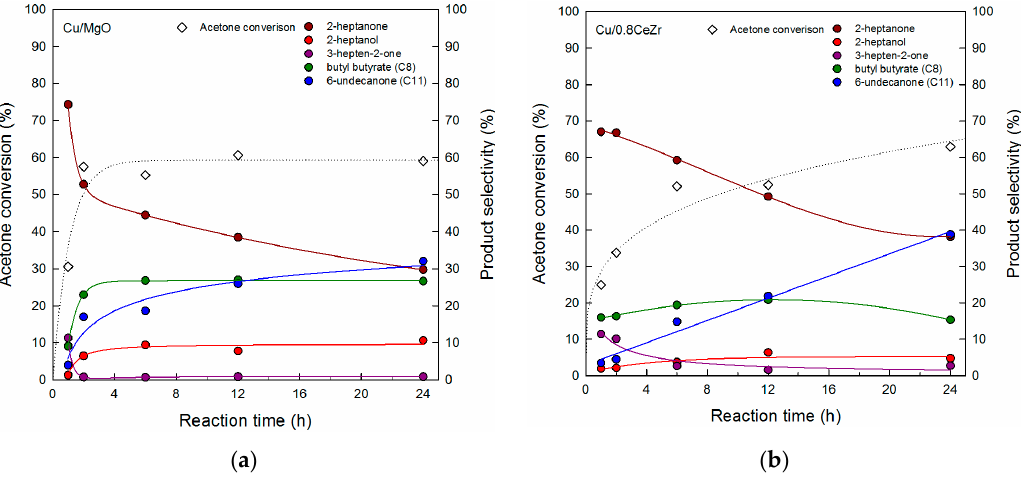
Figure 9. Acetone conversion and product selectivities plotted against the reaction time over ( a ) Cu/MgO and ( b ) Cu/0.8CeZr catalysts.